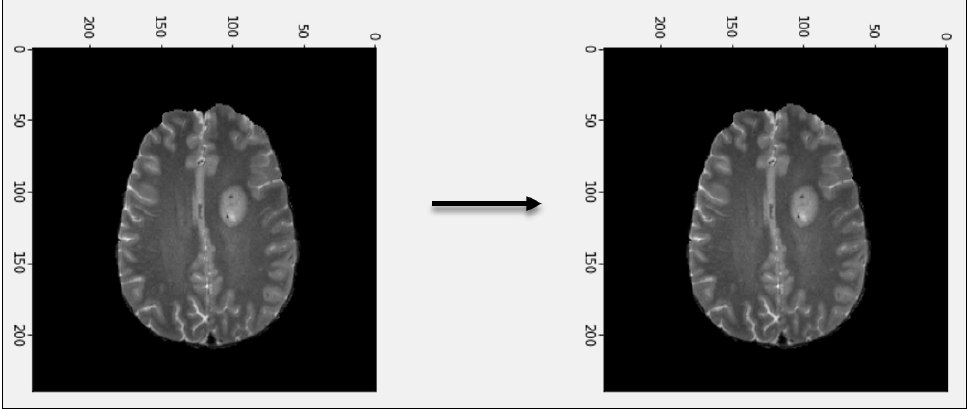
Figure 2. Pre-processing of the input images using a median